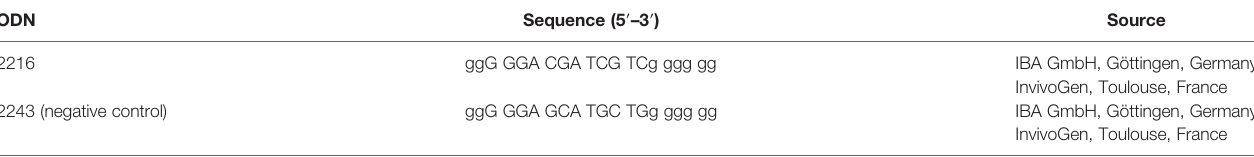
TABLE 1 | Synthetic oligonucleotides (ODNs) used for in vitro stimulation. ODN